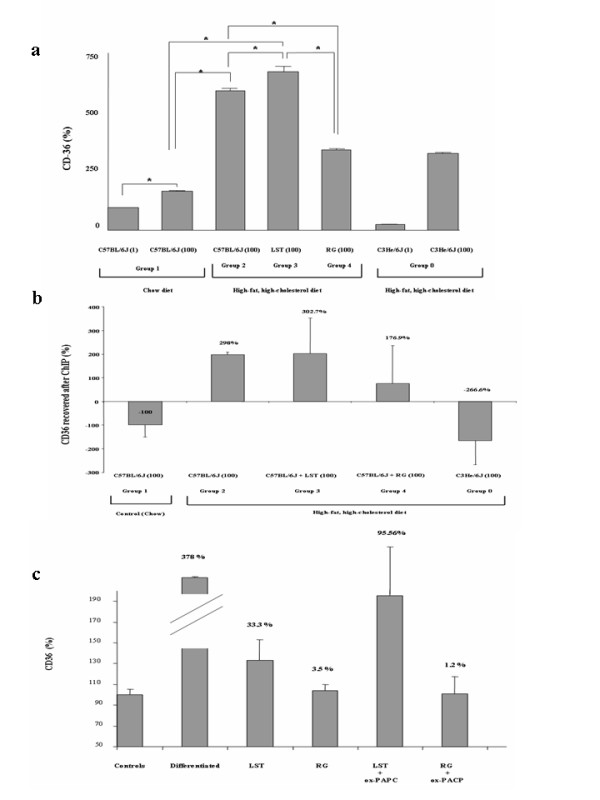
Rosiglitazone prevents Nrf2-depedent CD-36 up-regulation in hypercholesterolemic C57BL/6J mice. (a) CD36 mRNA relative expression in pooled liver samples from analyzed groups normalized to GAPDH expression. *P < 0.05. (b) ChIP with an Nrf2 antibody of study groups was used to amplify a CD36 promoter fragment. ChIP figures percentages indicate increments or decrements regarding C57BL/6J mice fed HFHC diet. Data of C57BL/6J mice fed chow diet was established as 100%. (c) Quiascent day-5 adipocytes incubated with RG and LST were treated with ox-PACP for additional 24 h. RNA was isolated to measure adipose protein 2 by conventional PCR and CD36 expression using real-time PCR. Values were normalized to GAPDH expression. Figure bar plots represent mean ± SEM percentage from vehicle-treated cells of at least 4 experiments with duplicate measurements.